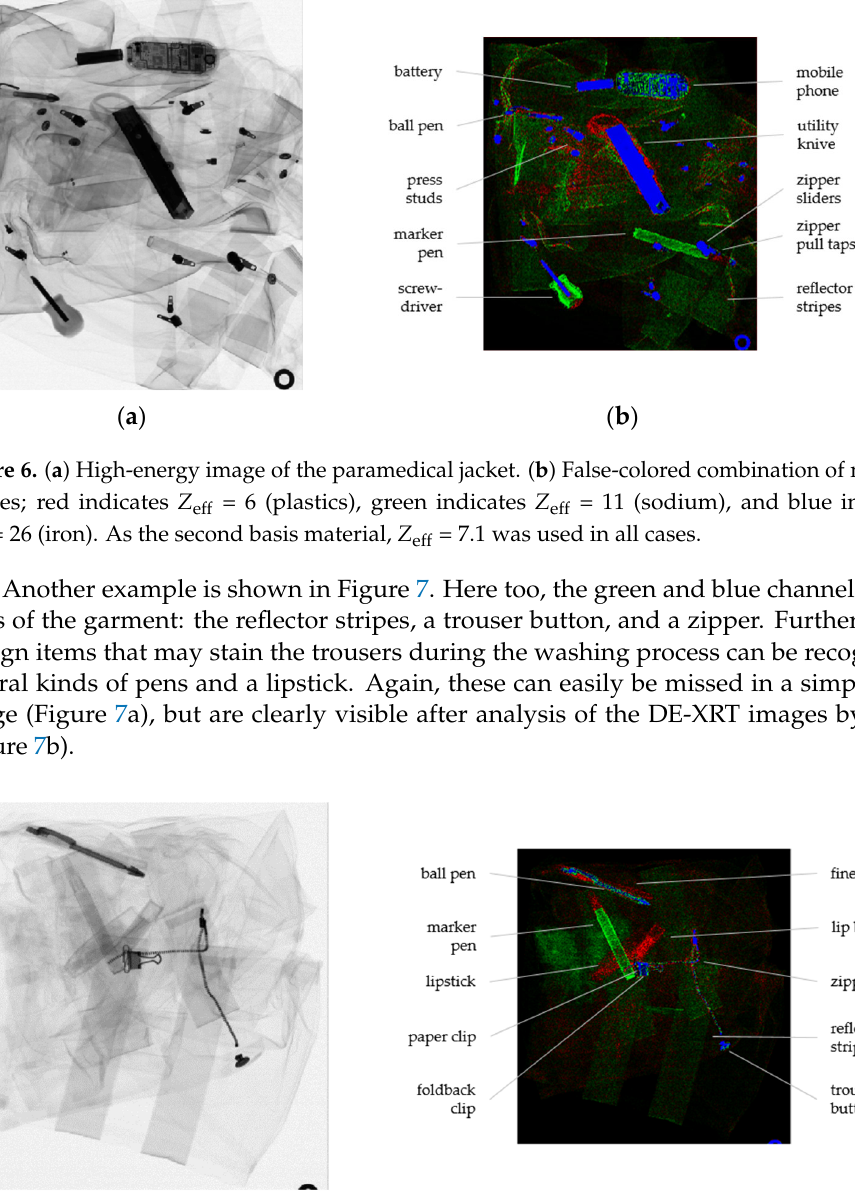
Figure 5. False ‐ colored combination of the material images shown in Figure 4; red indicates Z eff = 6 (plastics), green indicates Z eff = 11.2, and blue indicates Z eff = 26 (iron). Adapted from [26], licensed under CC BY 4.0.